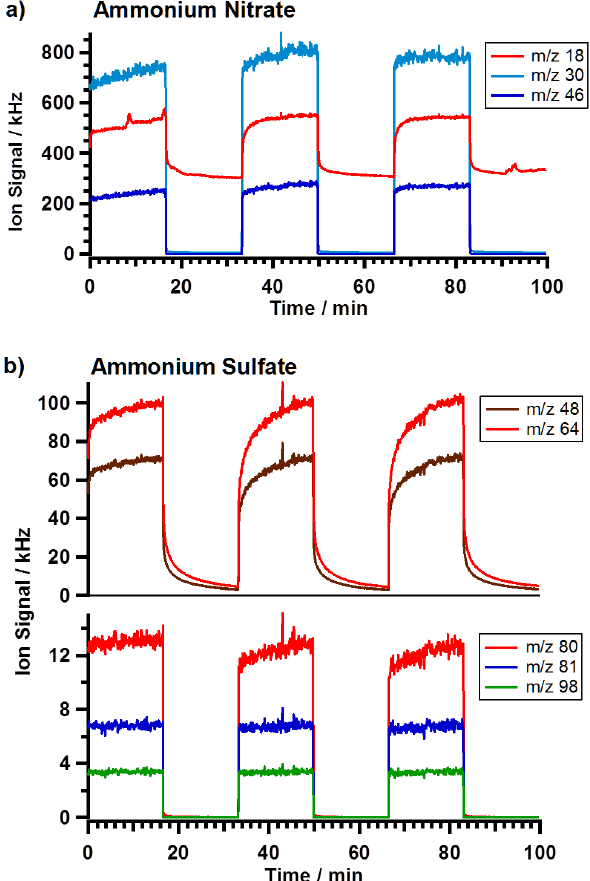
Figure 3. Time-resolved ion signal intensities from measurements of NH 4 NO 3 (a) and (NH 4 ) 2 SO 4 (b) for extended aerosol beam (beam-open) and instrument background (beam-closed) measure- ments. Precision of the measurements is <10%; vaporizer temper- ature was 600 ◦